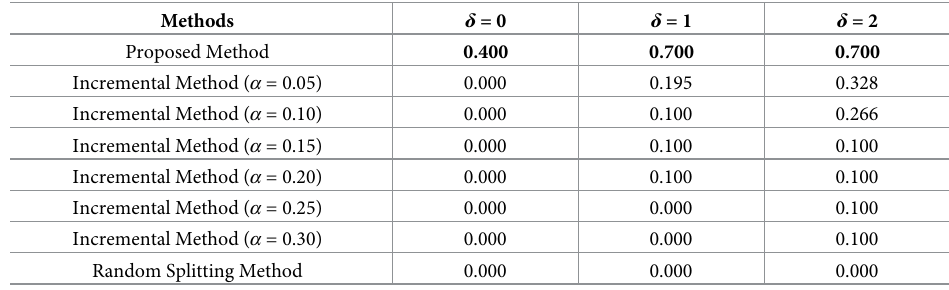
Table 2. Our segmentation scheme accurately (in terms of F1 score) detects ground-truth splitting points in syn- thetic